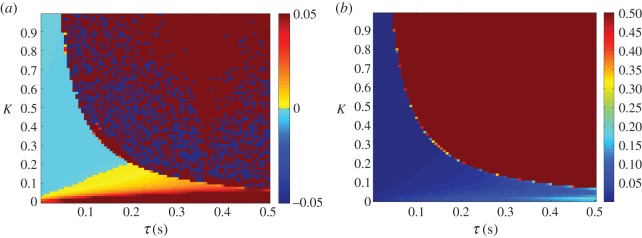
Lag (a) and lag-adjusted RMS error (b) between xtarget and xeffector, plotted as a heat map. τf is set to 0 s, while τ is varied between 0.01 and 0.5 s. Lag remains close to 0 to the left of the stability boundary (which can be approximated by Kτ=0.14), beyond which error rises above acceptable levels and lag can no longer be accurately measured. For this reason, the error is saturated at 0.5.